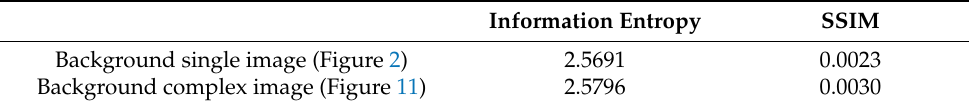
Table 3. Information entropy and SSIM for the two types of